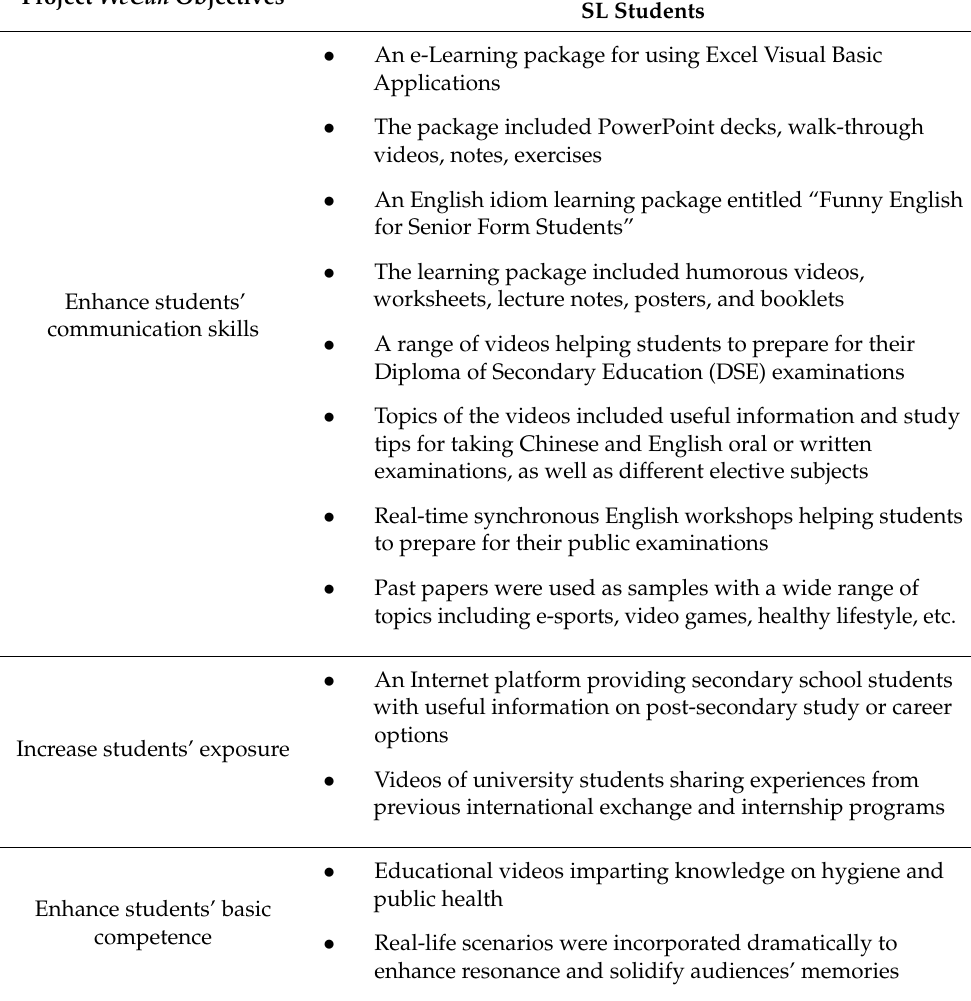
Table A1. Indirect SL activities and respective Project WeCan